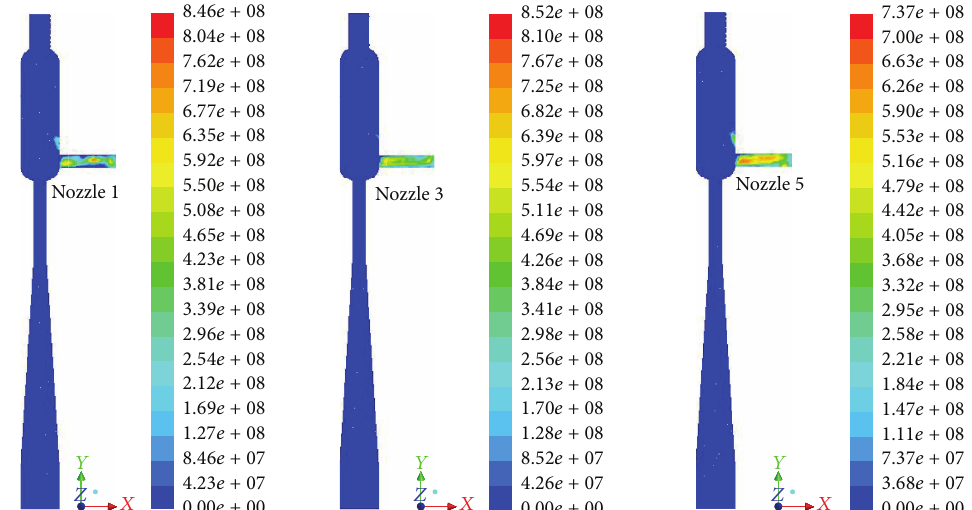
Figure 9: Contour of the number density of bin fraction 0 for nozzles 1, 3, and 5.